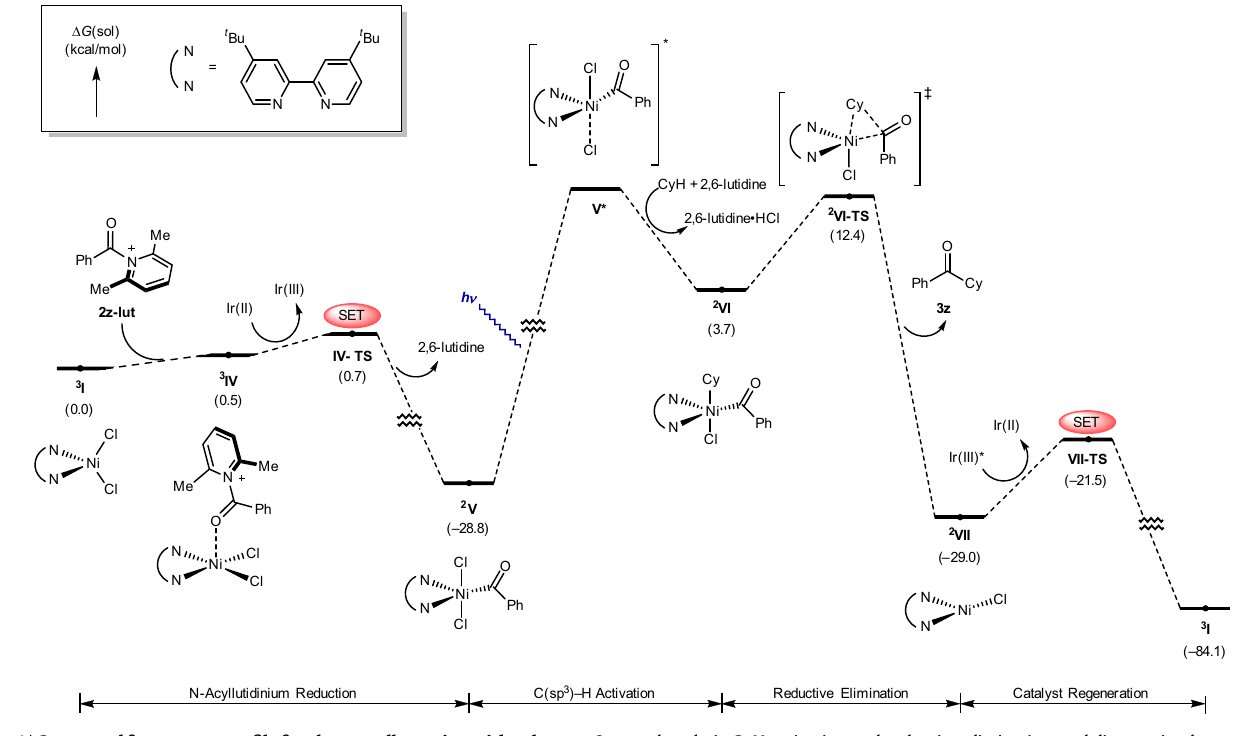
photolytic C – H activation and reductive elimination to deliver amino ketone pro- duct 3z . Energies are given in kcal/mol values.